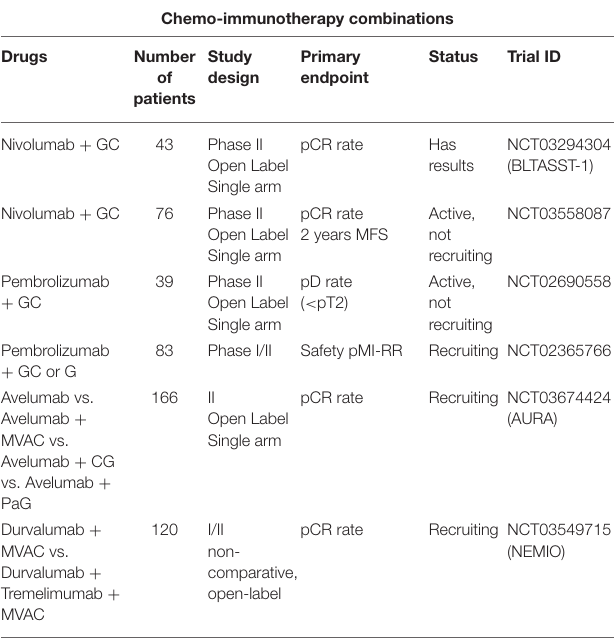
TABLE 3 | Overview of selected neoadjuvant trials in MIBC testing chemo-immuntherapy combinations.